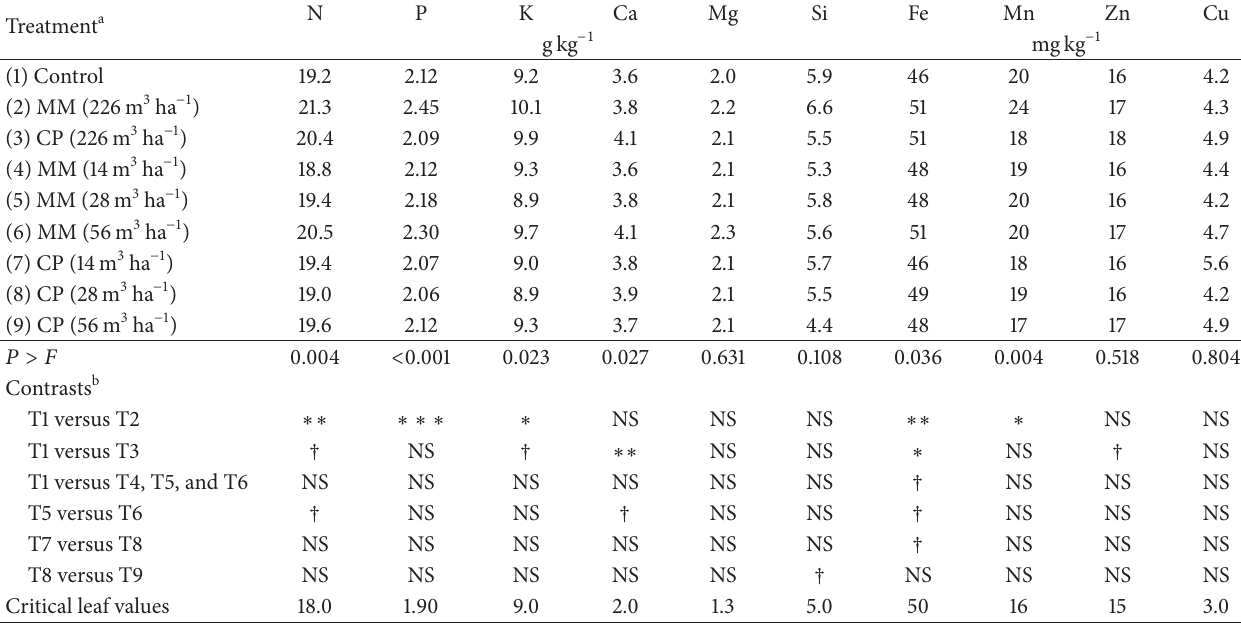
Table 7: Predicted least squares means, 𝑃 > 𝐹 , and significant contrasts for leaf nutrient concentrations for the first ratoon crop at Site 1. Critical leaf nutrient concentrations [19] are included for comparison.